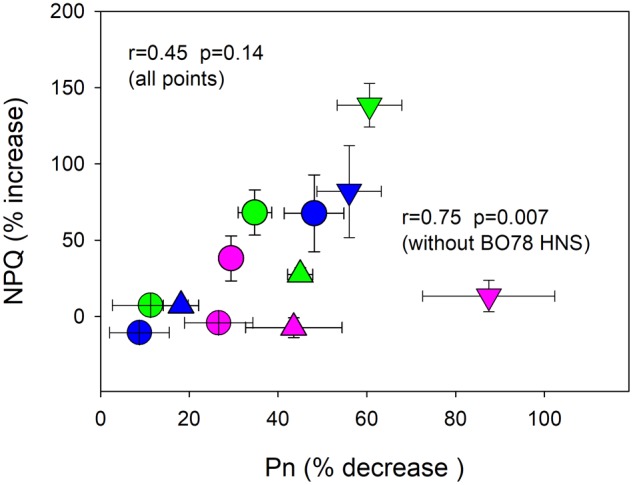
Relationship between percent decrease in photosynthesis and increase of non-photochemical quenching (NPQ). Values were calculated as percent of change of plants at 29 DAF relative to initial control plant values (at 14 DAF). Symbols represent treatments HNC (circles), LNC (crossed circles), HNS (down triangles), LNS (up triangles), and color represents genotypes Faro (green), UdeC9 (blue), and BO78 (pink). Mean values ± SE were calculated from four independent measurements. Linear Pearson’s correlation coefficient (r) was used to examine the correlations.